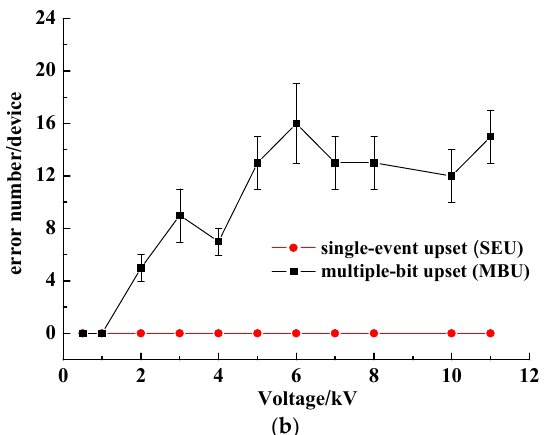
Figure 10. The types of bit-errors for the SRAM with ( a ) pulsed laser energy; and ( b ) SESD voltage. By comparing the characteristics of bit-errors obtained from the pulsed laser and ESD